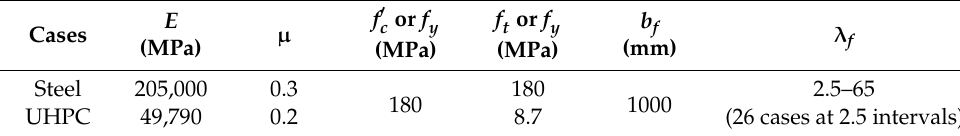
Table 3. Parameters of the GMNIA analysis.